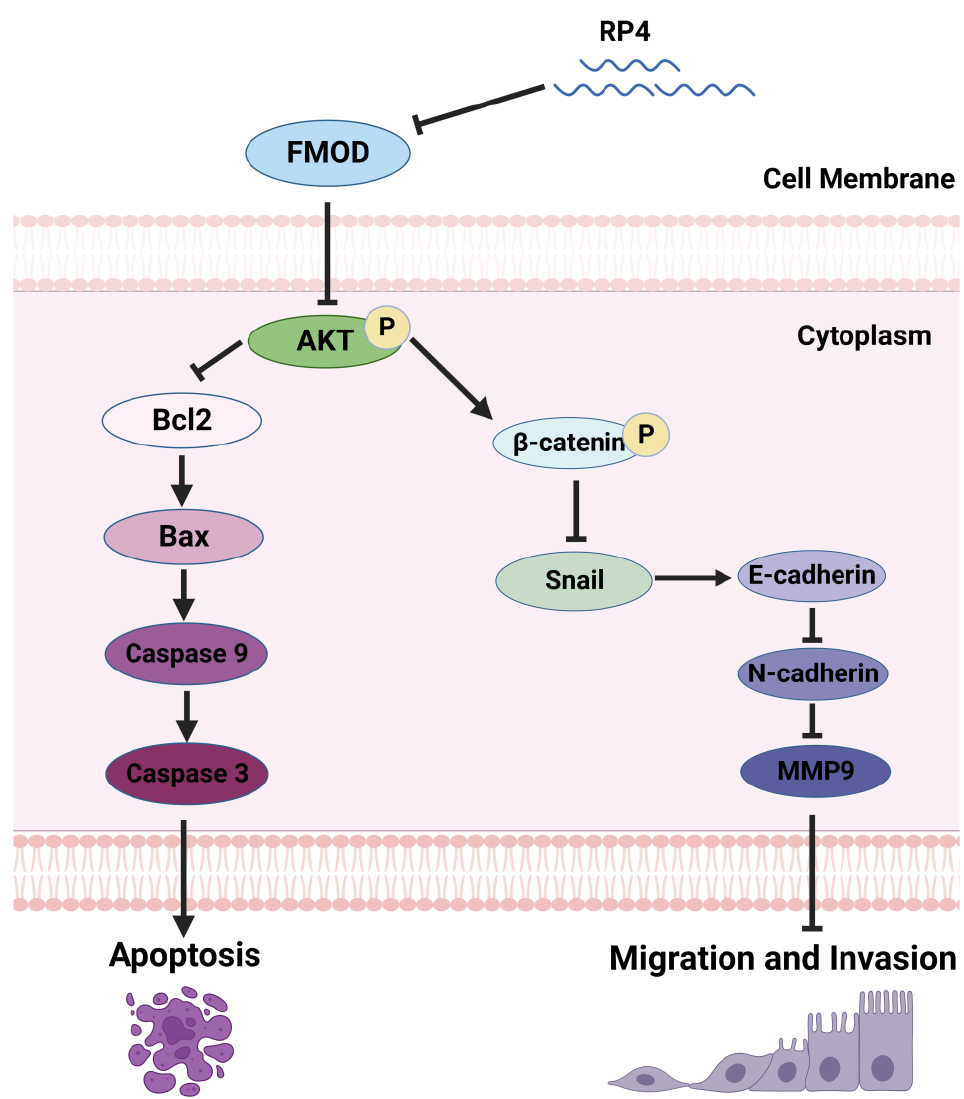
Figure 8. RP4 induces cell apoptosis and inhibits cancer metastasis via AKT and Wnt/ β -catenin signaling pathways. RP4 was ingested by colorectal cancer cells and blocked FMOD function, resulting in inhibiting the phosphorylation of AKT and further induing the activation of caspase 9 and phosphorylation of β -catenin. As apoptosis initiator, caspase 9 activated the cleavage of caspase 3, which directly promoted cell apoptosis. In the canonical Wnt/ β -catenin pathway, β -catenin phosphorylation led to degradation of β -catenin and reduced the accumulation of β -catenin in the cell nucleus. Thus, β -catenin phosphorylation indirectly inhibited MMP9 and cyclin D1 expression. In addition, blocked FMOD inhibited the phosphorylation of Erk and snail expression. Therefore, down-regulation of MMP9, cyclin D1, and snail repress cell migration or invasion by inhibiting EMT as well as down-regulation of N-cadherin and vimentin.